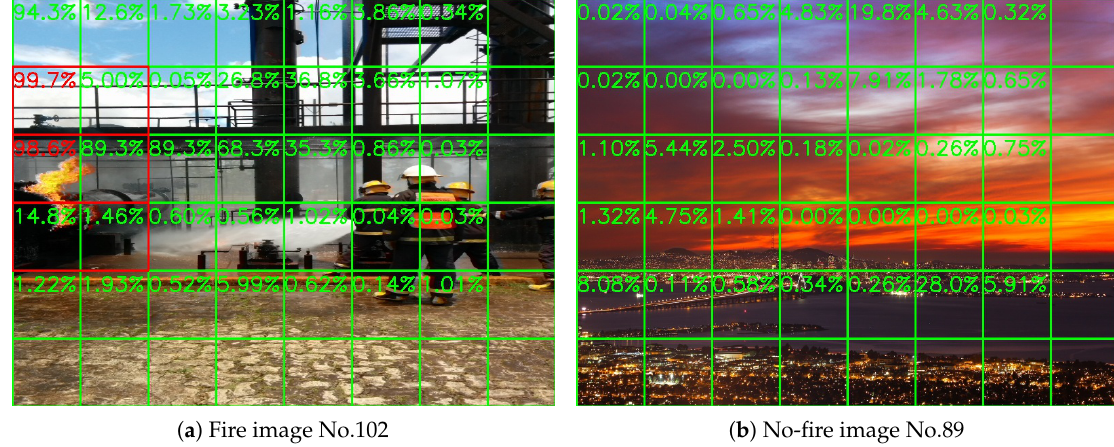
Figure 22. Test result on the BoWFire